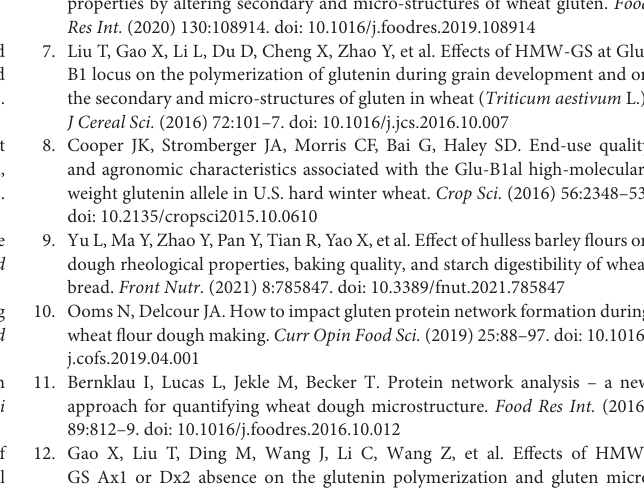
Supplementary Figure 1 | Gluten protein composition and microstructure of wheat and quinoa reconstituted flours and doughs. (A) The UPP% of wheat and quinoa reconstituted flours. (B–D) Microstructure indicated by the protein area, protein junctions and lacunarity of the wheat and quinoa reconstituted doughs. The data were derived from five captures of each sample and presented as mean value ± standard deviation. Supplementary Figure 2 | Image of formulated crispy biscuits appearances and textures with the scale bar of 1 cm. Supplementary Figure 3 | The line charts exhibiting unobvious relationship between biscuit properties and gluten, starch and rheological properties of quinoa-wheat reconstituted